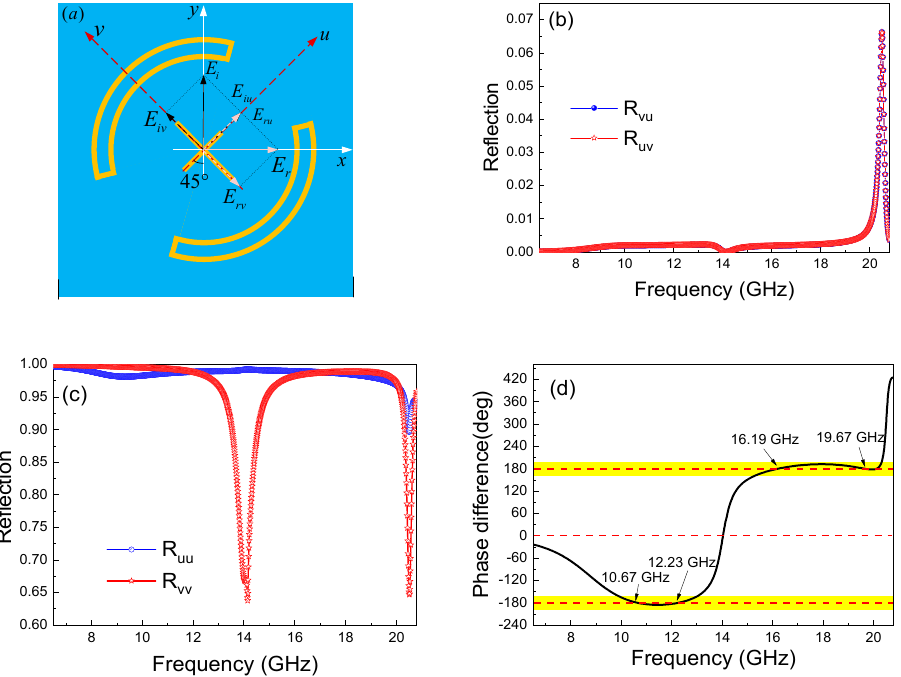
Figure 3. ( a ) Definitions of the u - and v -axes, ( b ) reflected amplitudes of the cross-polarization, ( c ) reflected amplitudes of the co-polarization, and ( d ) phase di ff erence of the co-polarization for the electric fields in the u - and v -axis directions.